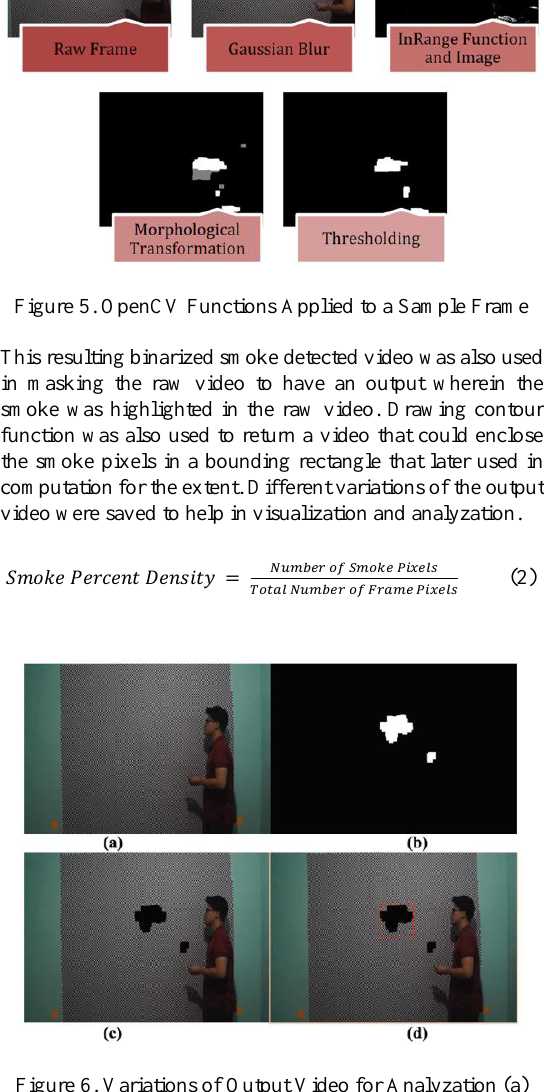
Figure 6. Variations of Output Video for Analyzation (a) raw video frame (b) binarized video frame (c) masked video frame (d) the masked video with contour frame The smoke detected video with contour output, that extracted